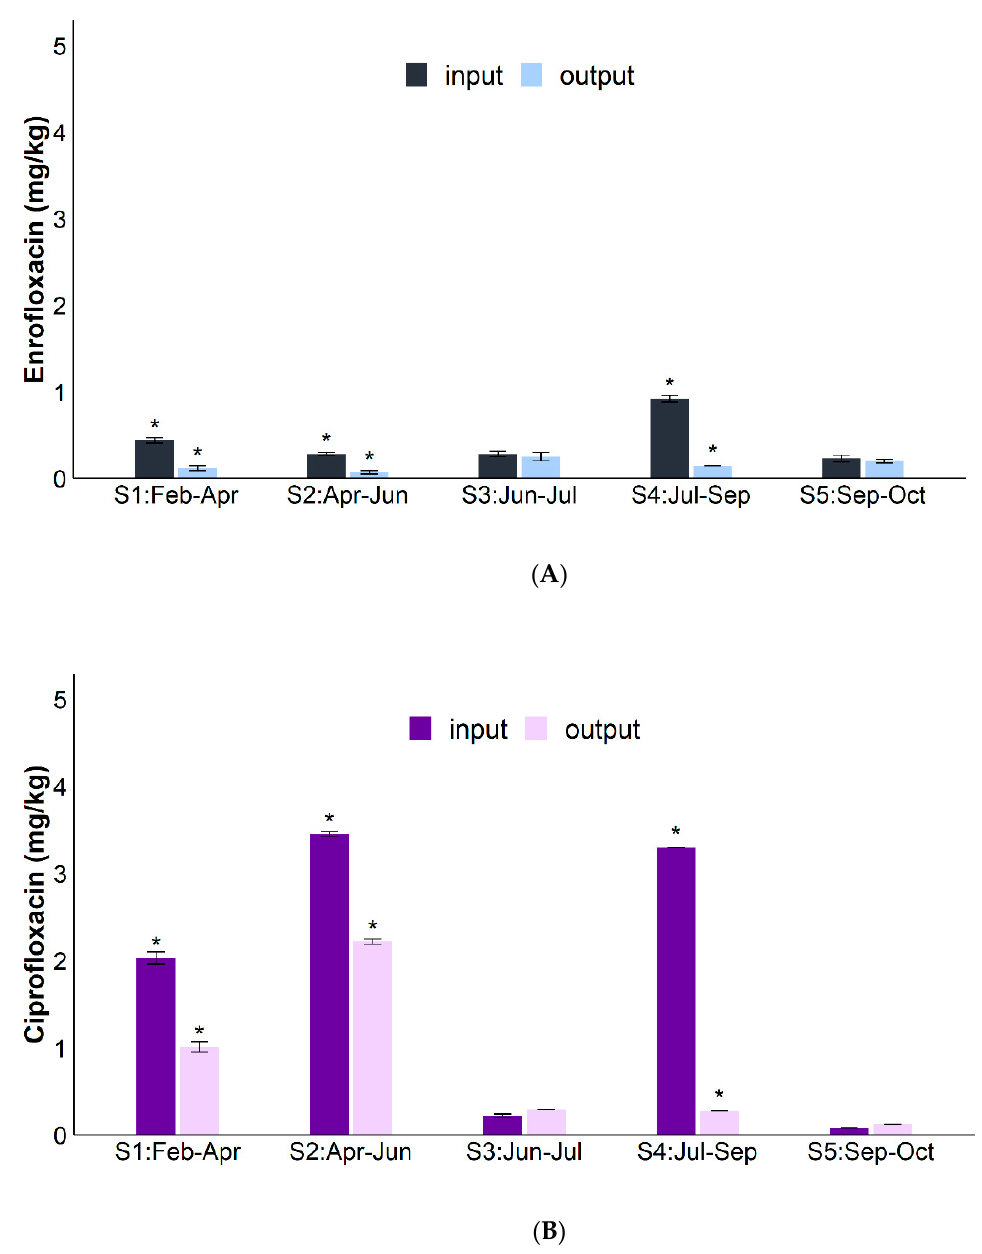
Figure 2. ( A ) Enrofloxacin and ( B ) Ciprofloxacin concentrations (mg/kg) in input and output samples collected during 2019 (S1: In Feb -Out Apr ; S2: In Apr– Out Jun ; S3: In Jun -Out Jul ; S4: In Jul -Out Sep ; S5: In Sep -Out Oct ). The significant differences ( t -test, p < 0.05) are marked with